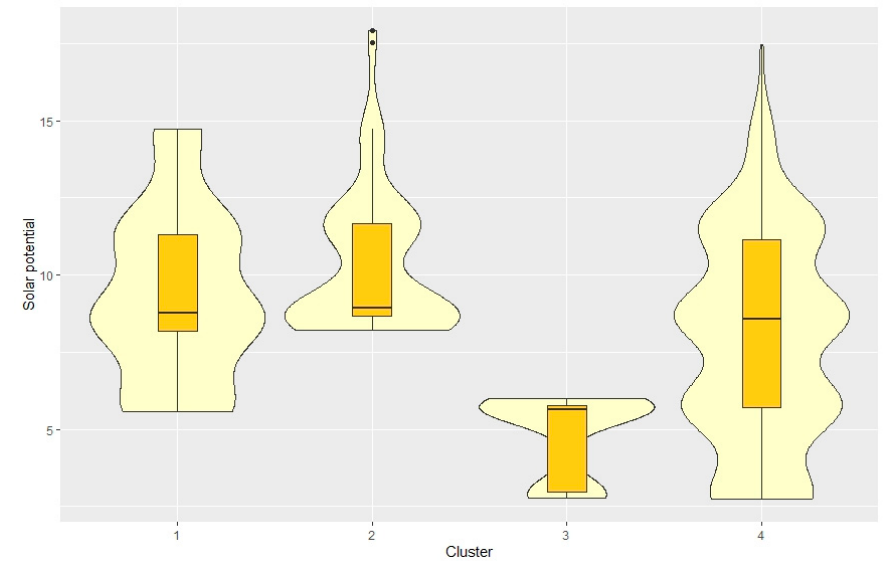
Figure 2. Solar potential distribution for clusters.